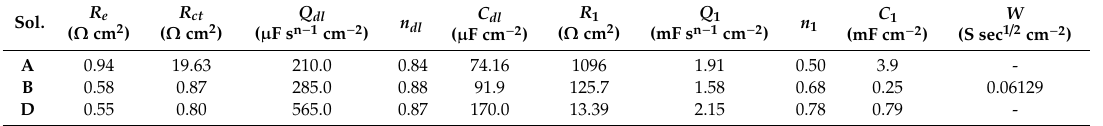
Table 5. Electrochemical parameters of Pb dissolution in bromide-containing solutions.